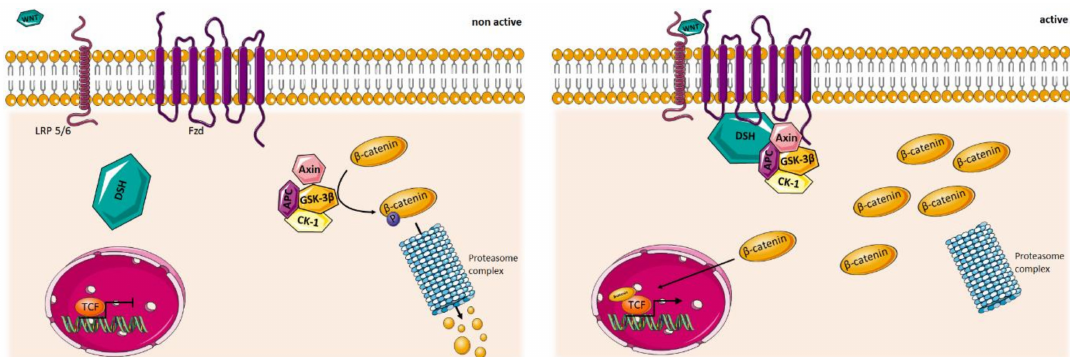
Figure 1. Schematic representation of the Wingless and Int-1 (WNT) / β -catenin signaling pathway. In the non-active state ( left panel ), β -catenin is phosphorylated by a multi-component complex containing glycogen synthase kinase 3 β (GSK-3 β ), Axin, adenomatous polyposis coli (APC), and casein kinase-1 (CK-1). This causes β -catenin to be phosphorylated for degradation by the proteasome complex. In the active state ( right panel ), a WNT ligand binds to its receptor and co-receptor, Frizzled (Fzd), and low density lipoprotein (LDL) receptor-related protein 5 or 6 (LRP5 / 6), respectively, and causes the recruitment of components of the β -catenin phosphorylating complex to the membrane together with disheveled (DSH). This leads to the cytoplasmic accumulation of β -catenin and its translocation to the nucleus, eventually binding members of the T-cell factor / lymphoid enhancing factor (TCF / LEF) transcription factors and activating transcription of target